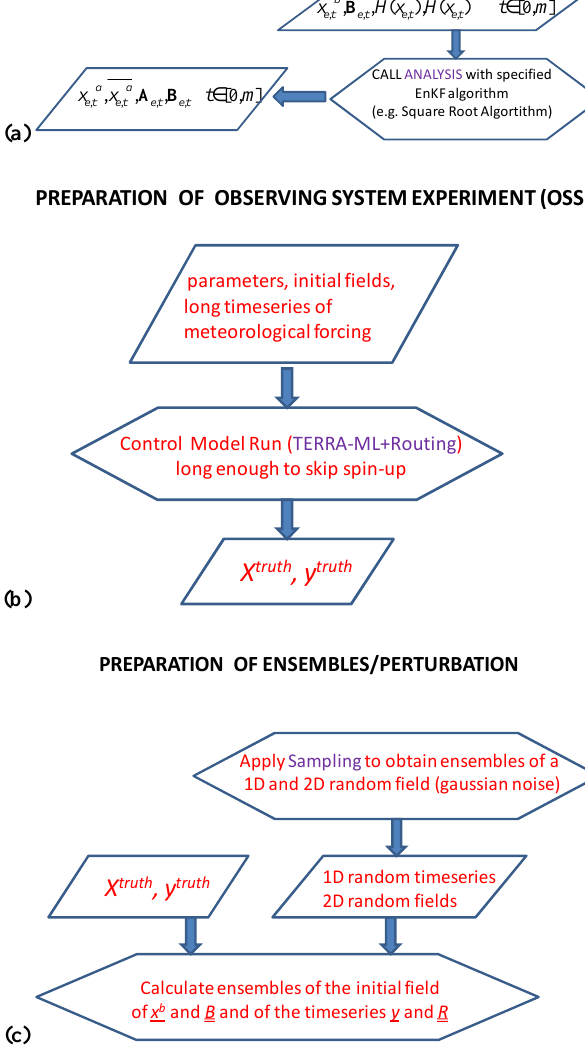
Fig. 1. Flow charts of (a) the streamflow data assimilation system for the soil moisture analysis of the initial time t =0. The applied model is TERRA ML with the river routing scheme as described by Warrach-Sagi et al. (2008), (b) the OSSE, and (c) the preparation of the perturbed soil moisture and streamflow observation